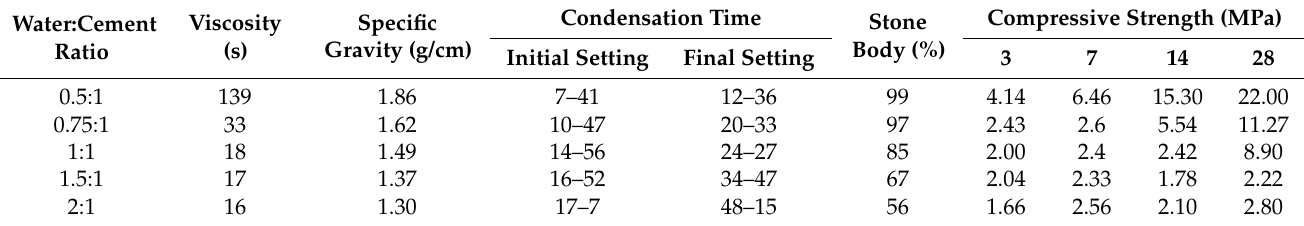
Table 2. Basic properties of single